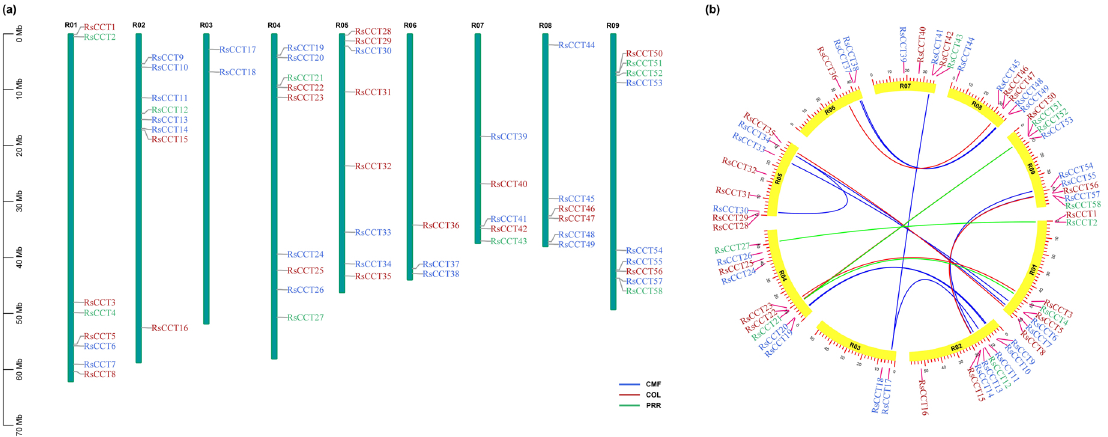
Figure 1. Chromosome localization ( a ) and duplication analyses ( b ) of RsCCT genes. Gene codes represented different groups with different colors in ( a ). Different colored lines in ( b ) were used to connect synteny genes of different